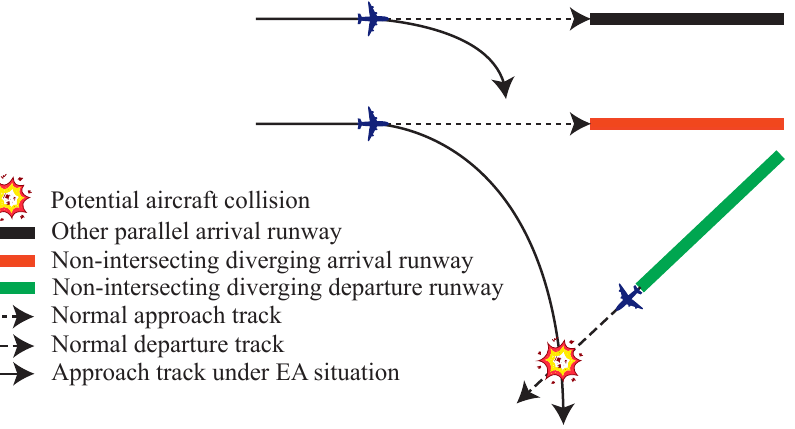
Figure 1. Schematic diagram of emergency avoidance (EA) situation.